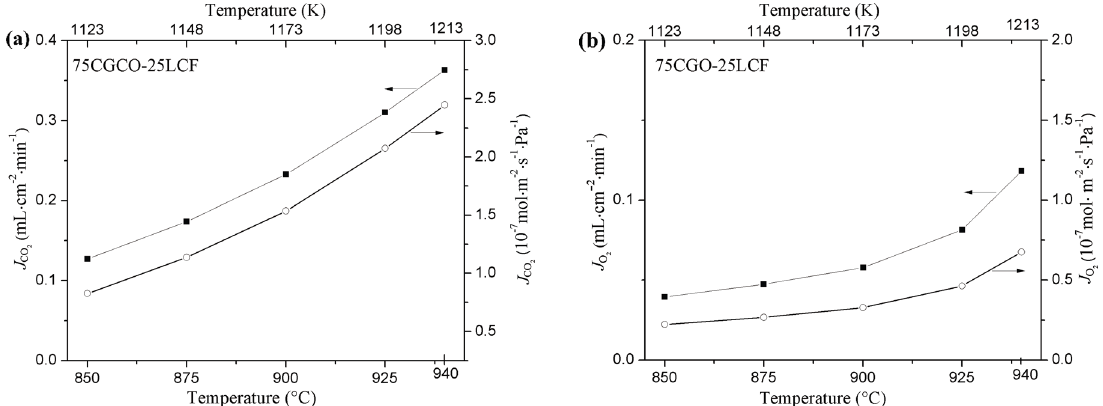
Fig. 9 Experimental permeation fluxes observed in the studied temperature range for the 75CGCO–25LCF/carbonate and (b) J O membrane: (a) J CO 2 2